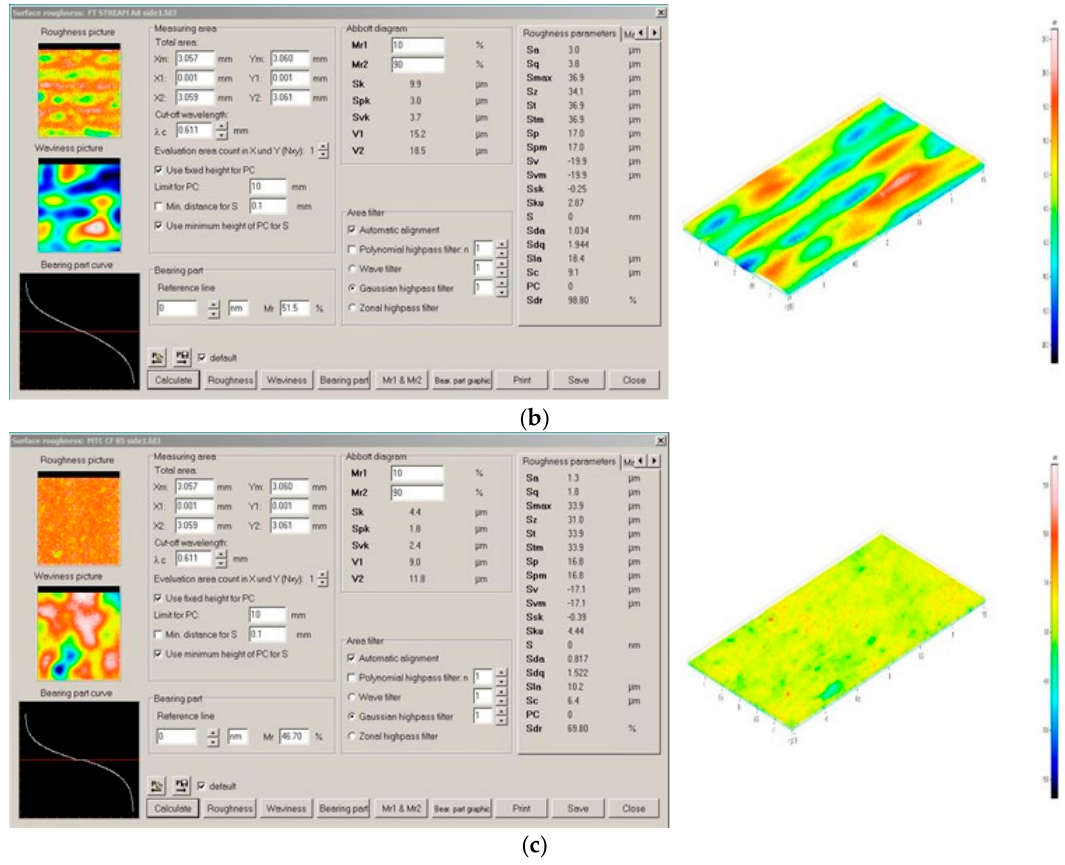
Figure 15. A 3D map assessment of AM part morphology before and after finishing processes. ( a ) Pre-processing 3D areal surface roughness parameters; ( b ) Stream finishing 3D areal surface roughness parameters; ( c ) HE centrifuge finishing 3D areal surface roughness parameters.